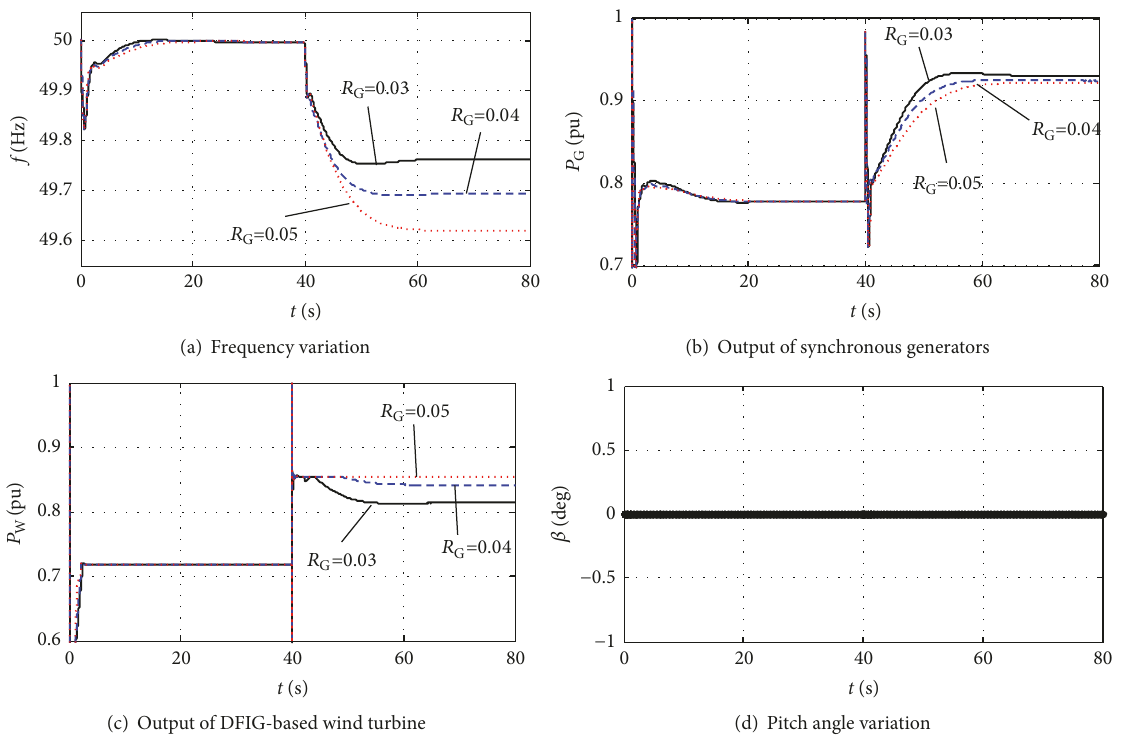
Figure 7: Simulation curves of the maximum power tracking area when frequency change is greater than